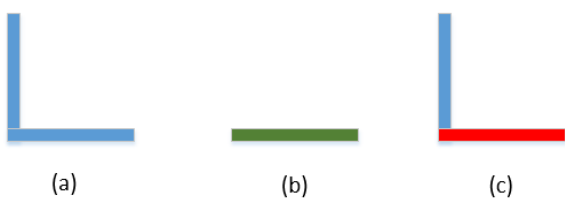
Figure 1: Illustration of partial similarity. (a) and (b) are two objects. The red part in (c) shows the overlap between (a) and (b). Actually, (b) is a part of